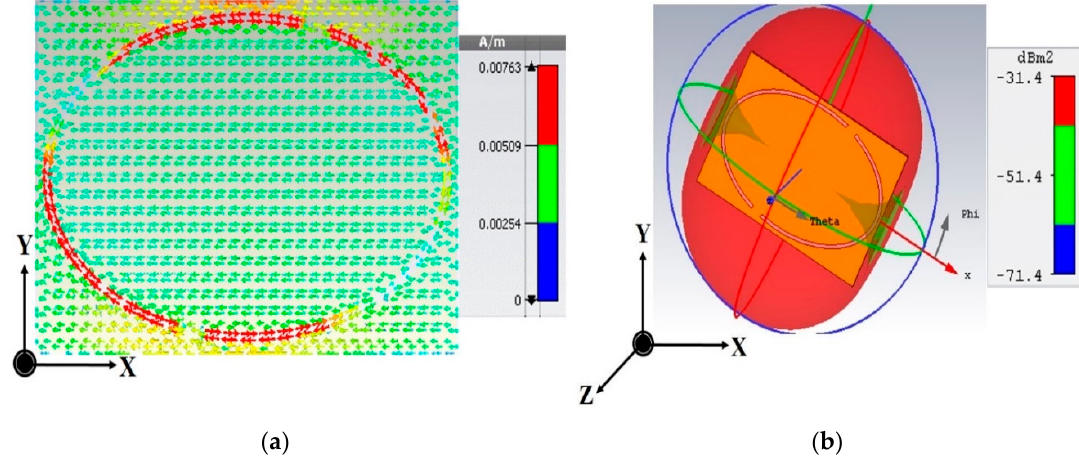
Figure 5. ( a ) Current density at 4.1 GHz. ( b ) 3-D radiation pattern of dual resonators.